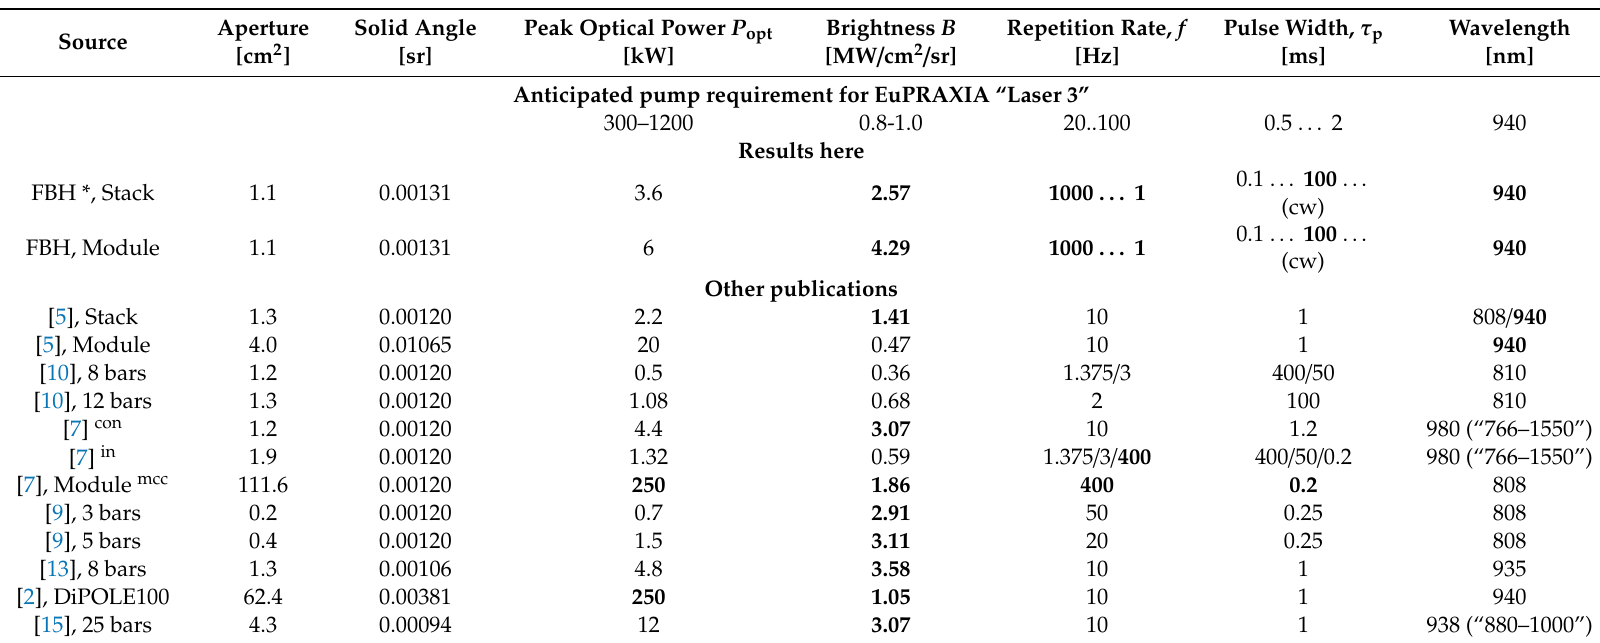
Table 1. Performance parameters of high-energy class diode laser (HEC-DL) pulsed pump modules compared to expected requirements for large scale high-repetition rate systems such as EuPRAXIA (numbers in bold show where there is a match to